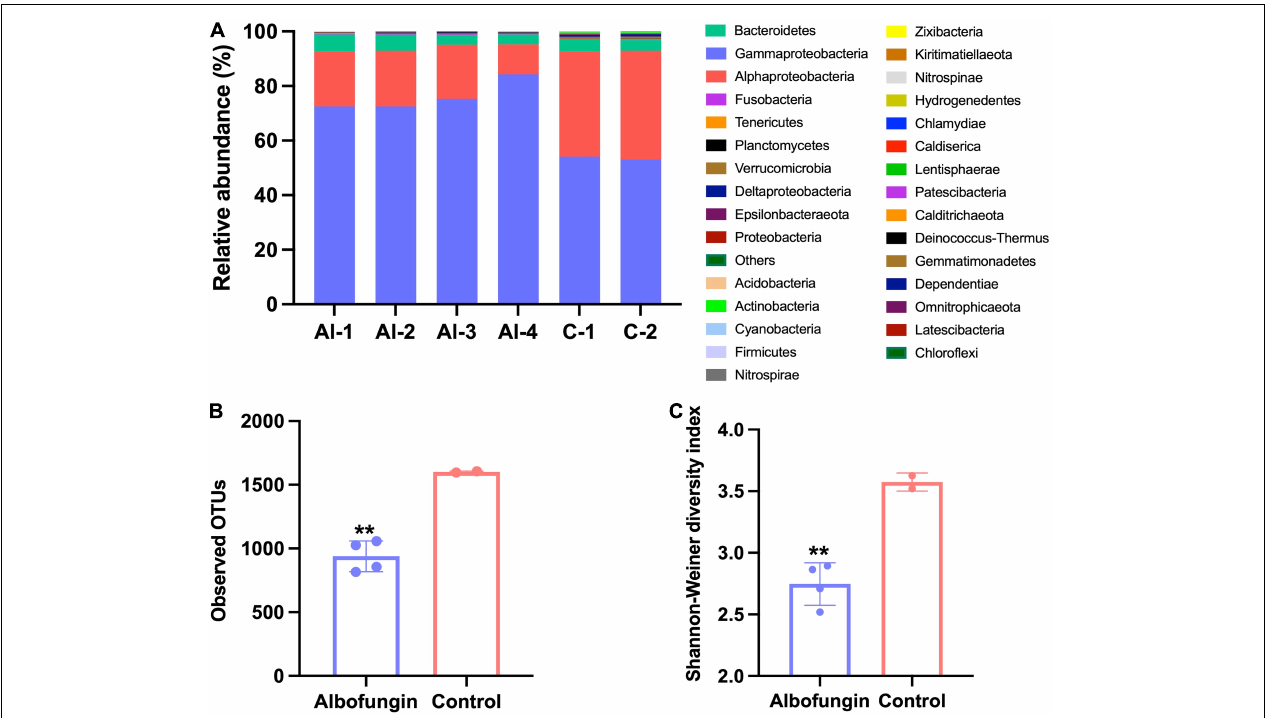
FIGURE 6 | Microbial community structure alteration by albofungin-based copolymer coatings based on 16S rRNA amplicon analysis. (A) Relative abundance of the major bacterial phylum of biofilms developed in 5 wt% albofungin-based copolymer coatings and control with only copolymer coatings (Proteobacteria are further classified into the classes). (B) Observed OTUs of albofungin-based copolymer coatings and control with only copolymer coatings. Error bars represent SD. Significant differences were analyzed by Student’s t -test, ** p < 0.01. (C) Shannon–Weiner diversity index of albofungin-based copolymer coatings and control with only copolymer coatings (al-1, al-2, al-3, al-4, and control-1, control-2). Error bars represent SD. Significant differences were analyzed by Student’s t -test, * p < 0.05, ** p < 0.01, and *** p <